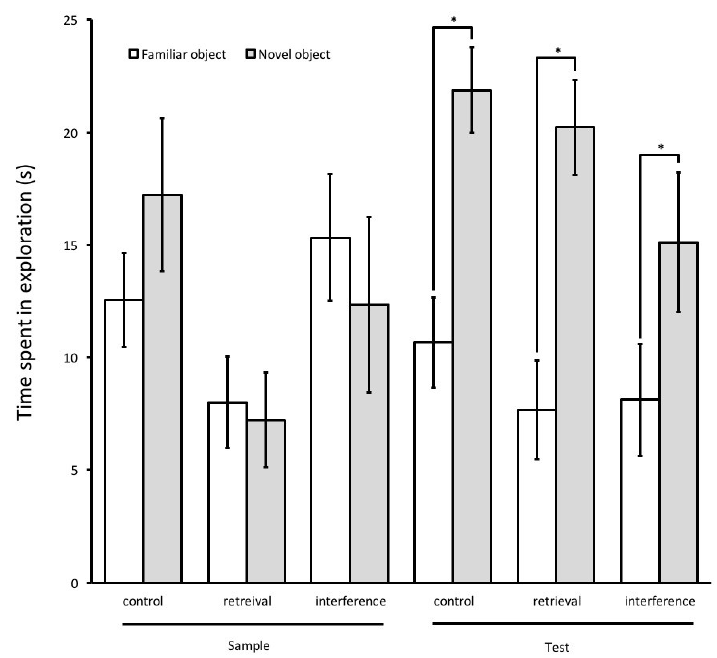
Figure 4. Time spent exploring objects (kindling group). In all three groups during the test phase, kindled rats explored the novel object more than the familiar one. The total amount of object exploration in seconds the test phase is reported as Mean ± SEM. * p < 0.05.